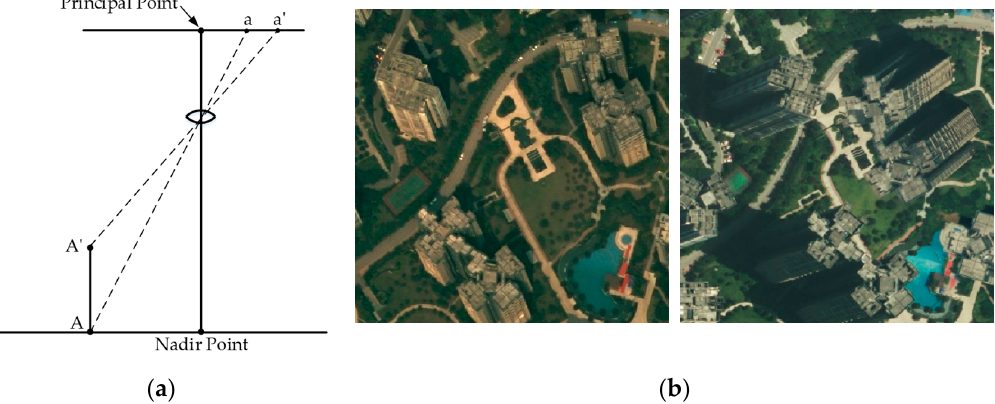
Figure 1. Underlying problems in building change detection: ( a ) Illustration of relief displacement and ( b ) image pairs including high-rise inclination buildings with greatly different relief displacements.